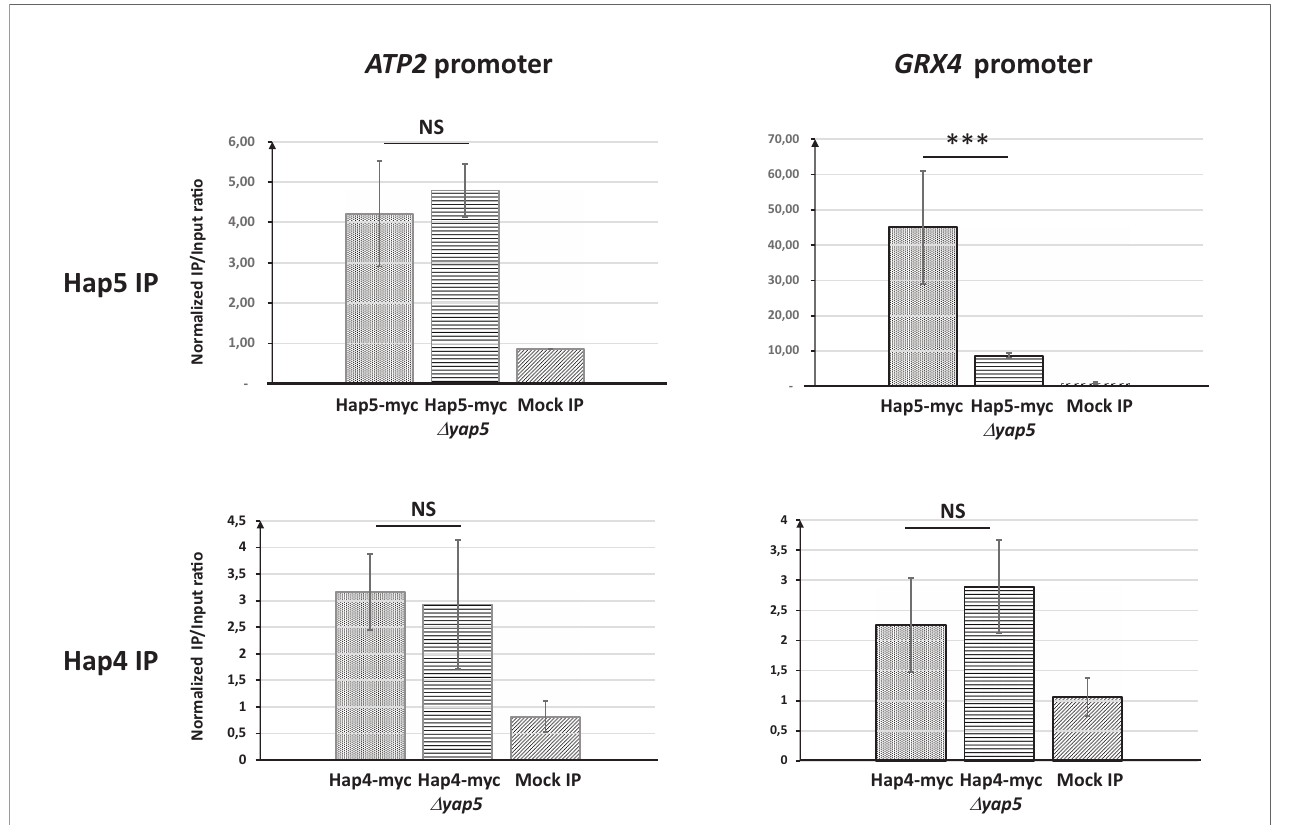
FIGURE 4 | Impact of the absence of YAP5 on the binding of Hap5 and Hap4 on the promoters of ATP2 and GRX4 . ChIP-qPCR was performed on strains expressing either a myc-tagged Hap5 (upper panels) or Hap4 (lower panels) in presence (Hap5-myc and Hap4-myc) or absence (Hap5-myc yap5 D and Hap4-myc yap5 D ) of YAP5 . All strains were grown in glycerol media. The values on the histograms represent the IP/Input ratios of the ATP2 (left panels) or GRX4 (right panels) promoters relative to the enrichment of the ACT1 promoter (used as an internal control). The experiments were performed four times on biologically independent samples. Error bars hence represent the standard error of the mean. The results of a t-test comparing the enrichments obtained for the wild type YAP5 and D yap5 genetic backgrounds are symbolized as follows: ***p < 0.01, NS: p >